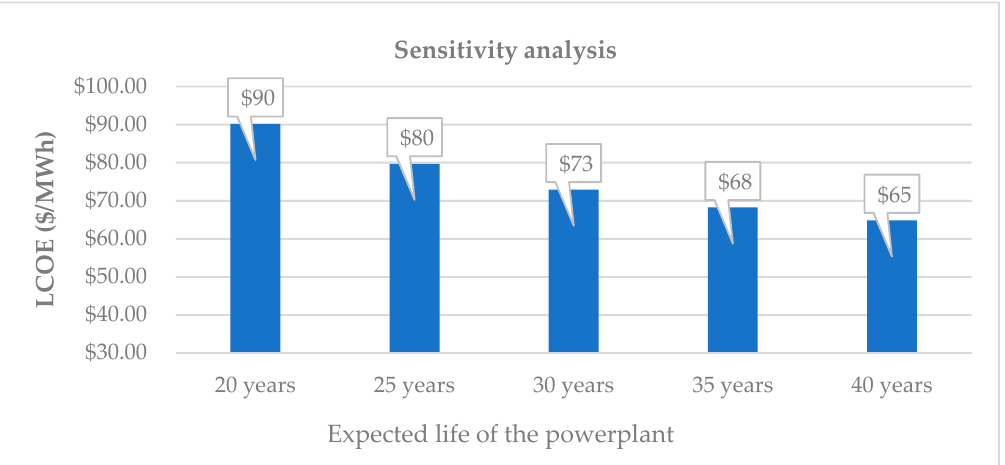
Figure 14. Sensitivity analysis of LCOE.